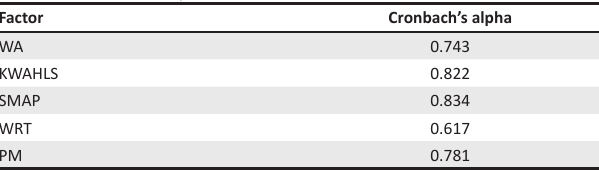
TABLE 13: Cronbach’s alpha.